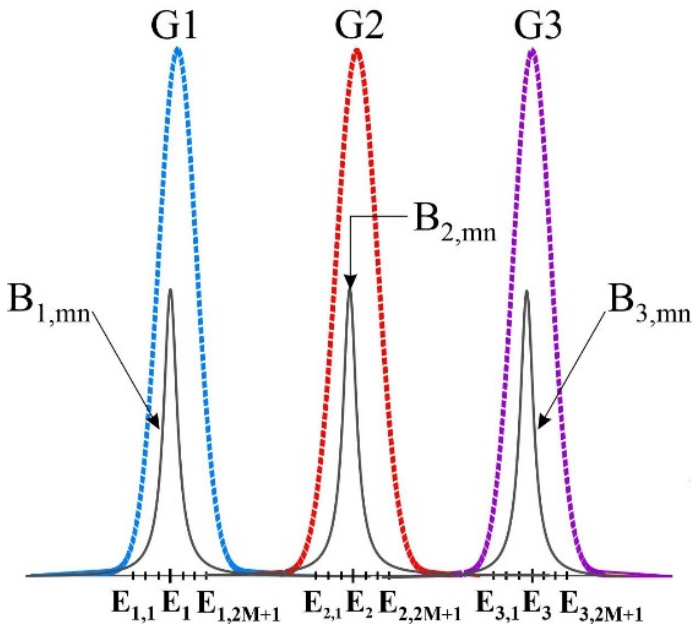
Figure 8. Homogenous and Inhomogeneous Broadenings for three groups of QDs.